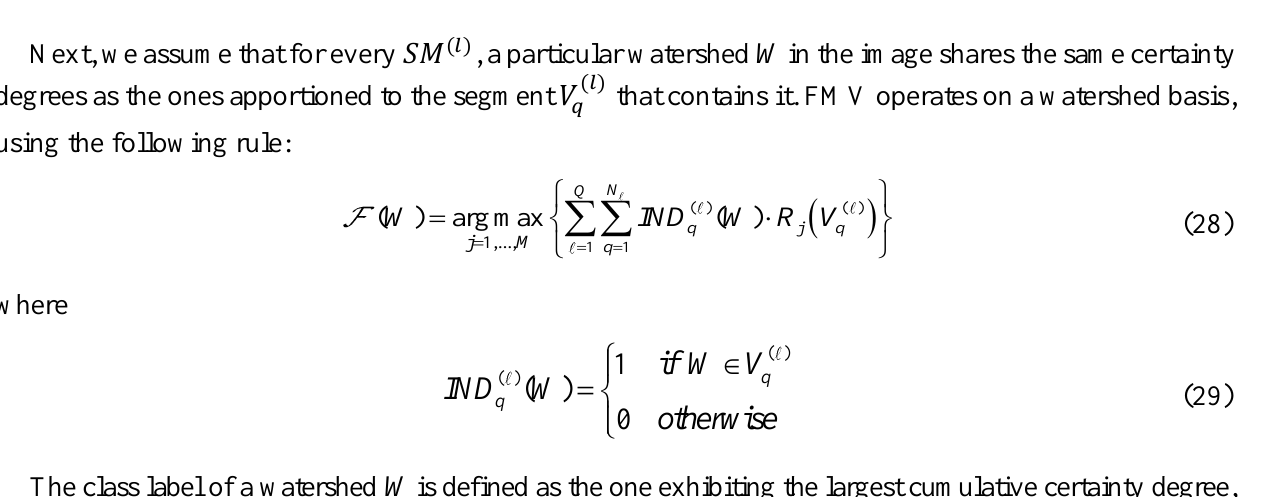
Figure 7. ( a ) Fuzzy Majority Voting Fusion; ( b ) MSF-based